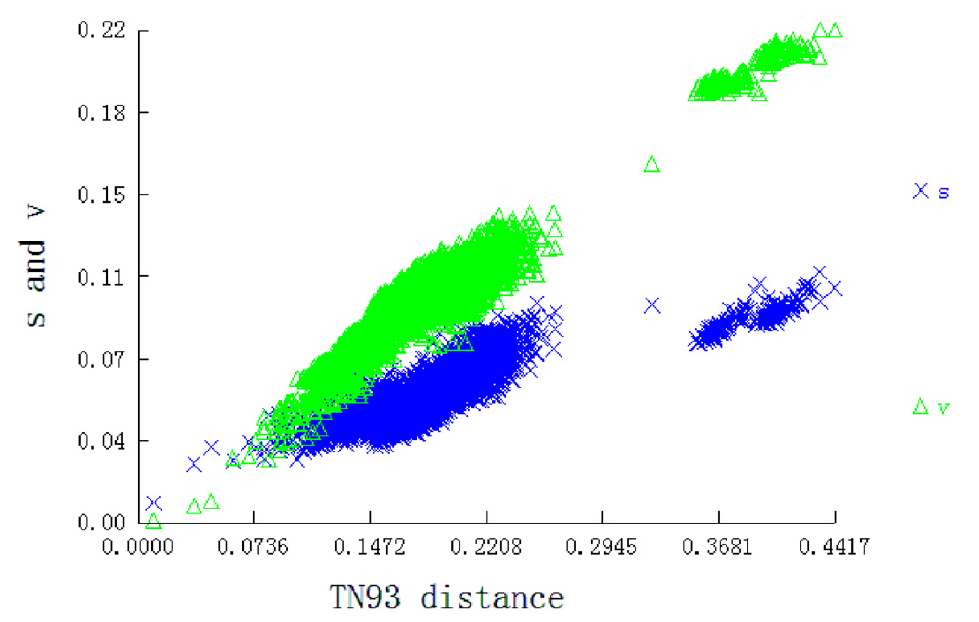
Figure 5. Substitution patterns of 13 PCGs matrices. The graph represents the increase in TN93 dis ‐ tance.